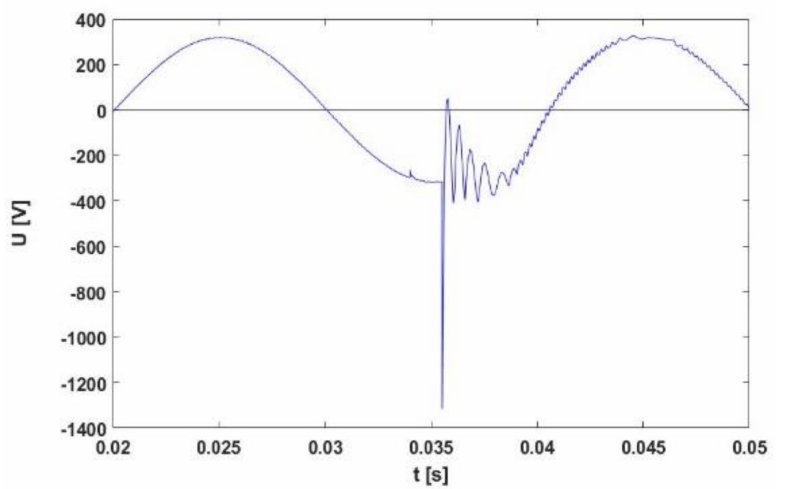
Figure 9. Input voltage waveform in the microinverter section disturbed by voltage surge with negative